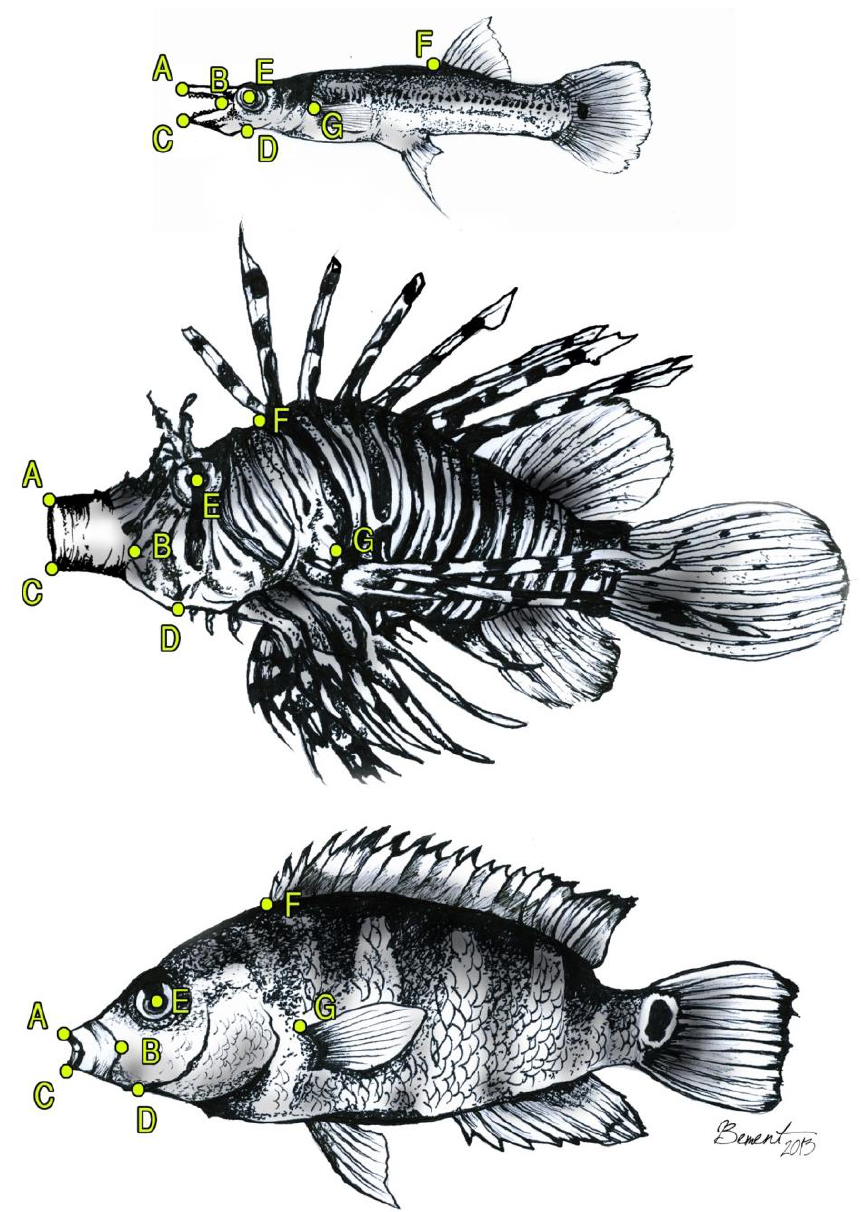
Figure 2. Diagram of the pike killifish, Belonesox belizanus ( top ), lionfish, Pterois volitans ( middle ), and Mayan cichlid, Cichlasoma urophthalmus ( bottom ) showing the homologous hotspots used to measure peak gape (= maximum distance measured from the anteriormost tip of the premaxilla (A) to the anteriormost tip of the dentary (C)), peak hyoid depression (= maximum distance between the center of the eye (E) to the anteriormost tip of the hyoid bar (D)), peak lower-jaw rotation (= maximum posteroventral rotation of the lower-jaw, measured as the angle formed by line segments AB (= jaw-joint) to BC), and peak cranial rotation (= maximum posterodorsal rotation of the neurocranium, measured by the angle formed by line segments AG (= dorsal tip of the pectoral-fin base) to GF (= anterior tip of the dorsal-fin base)).